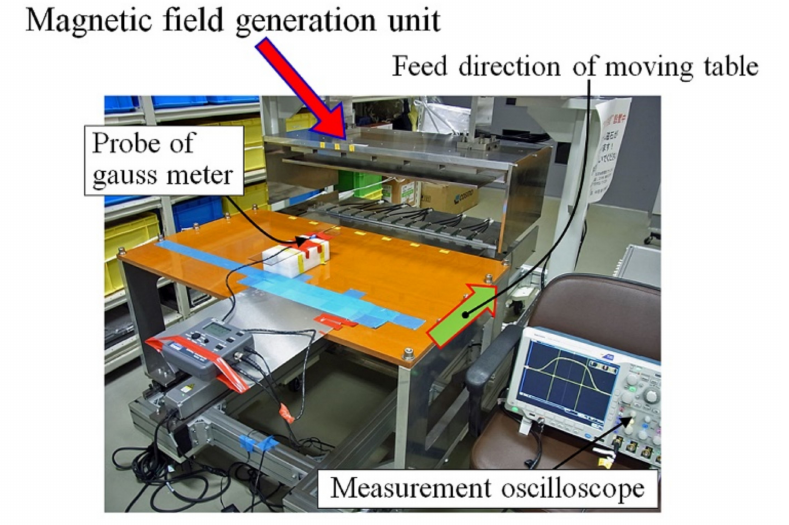
Figure 6. Perspective view of the fabricated measurement